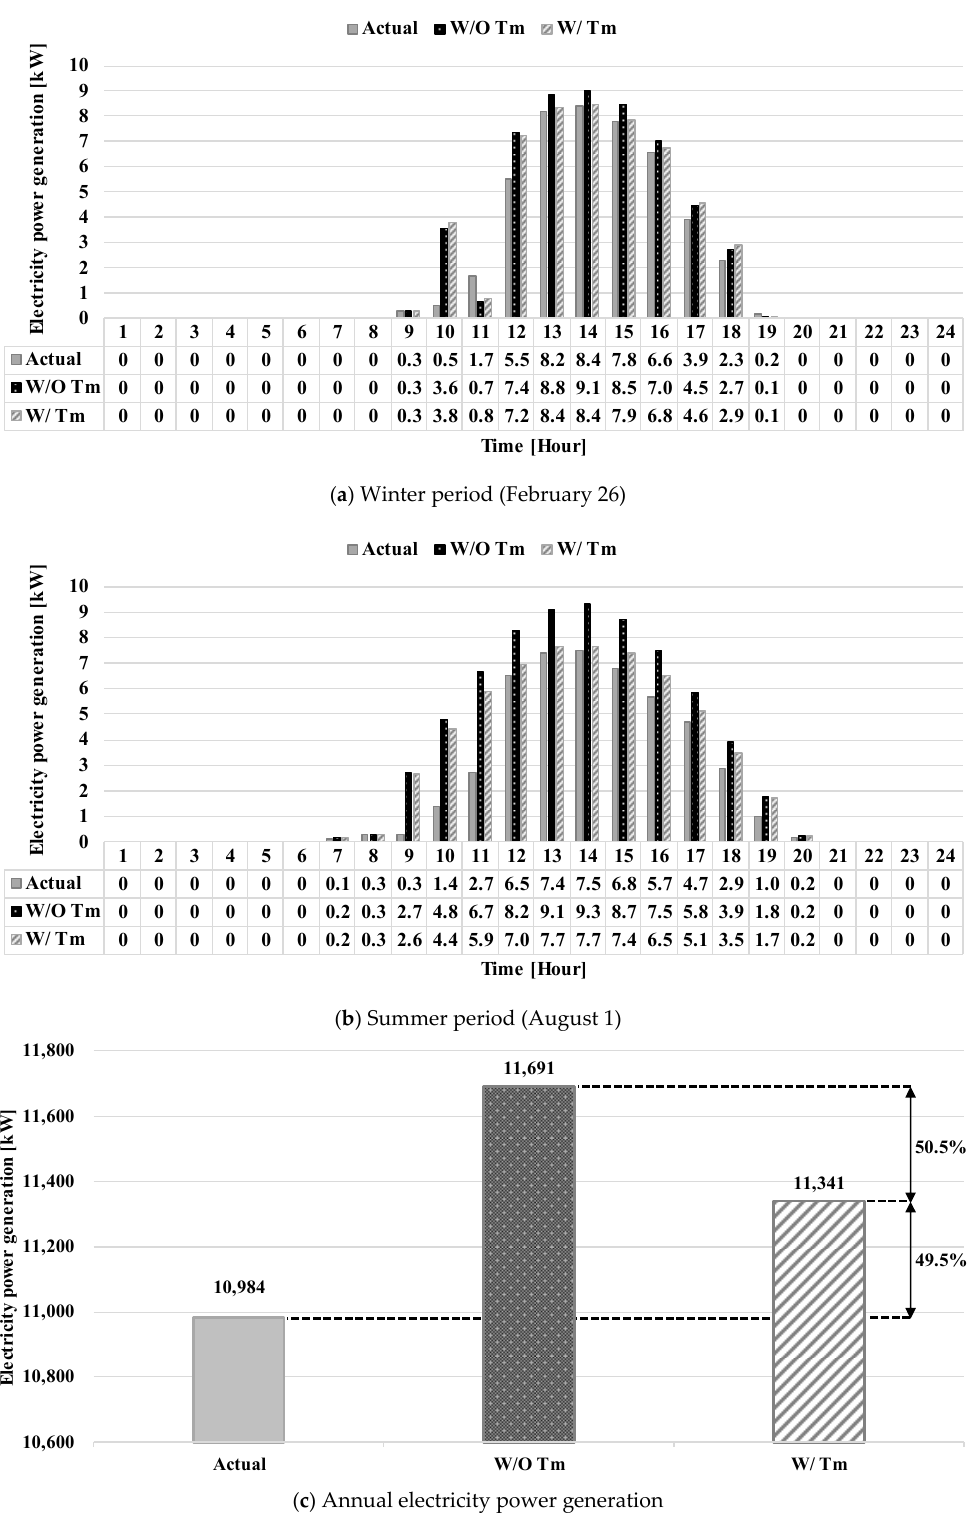
Figure 11. Electricity power generation according to improvement of the module efficiency.